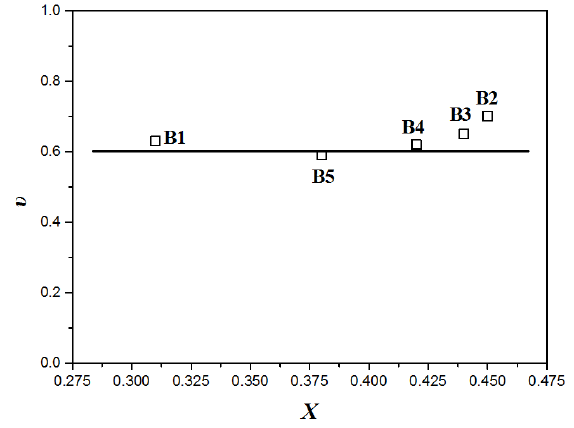
Figure 10. The relationship of structure constant ( υ ) with branching frequency ( X ).